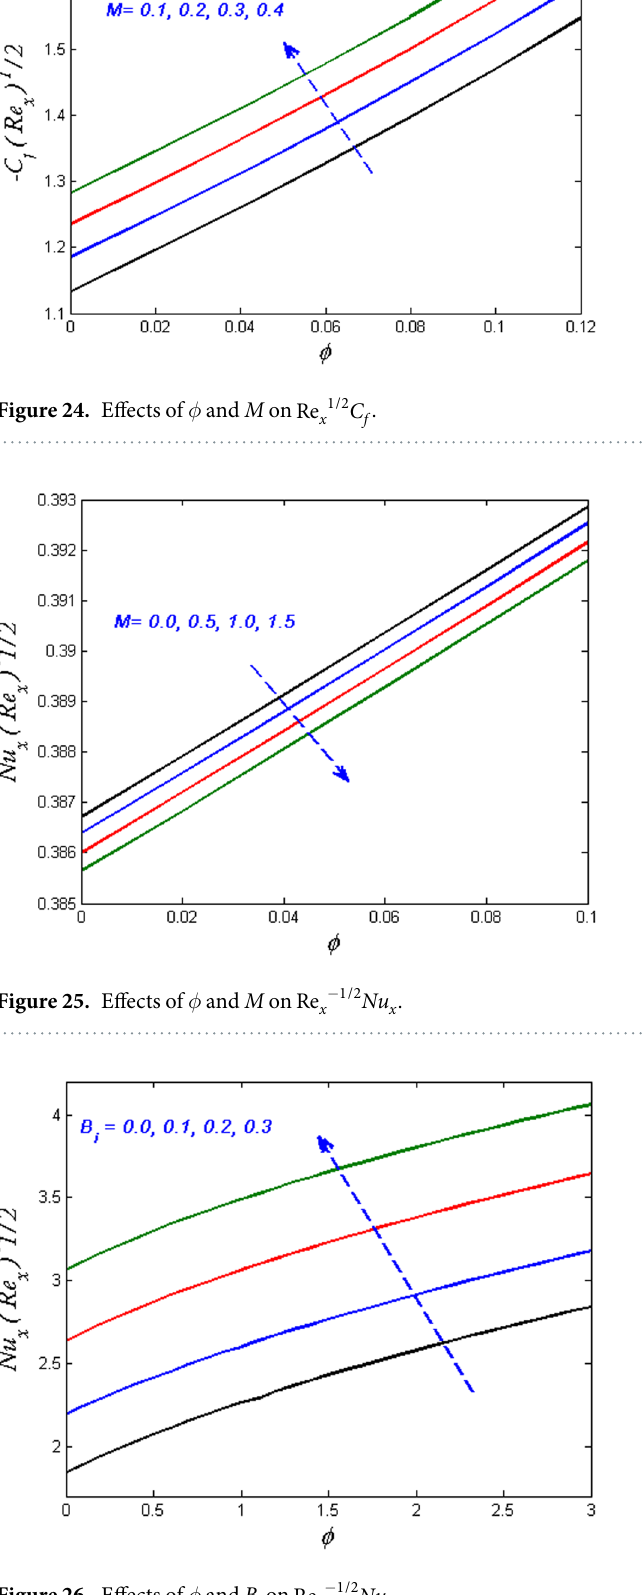
Figure 26. Effects of φ and B i